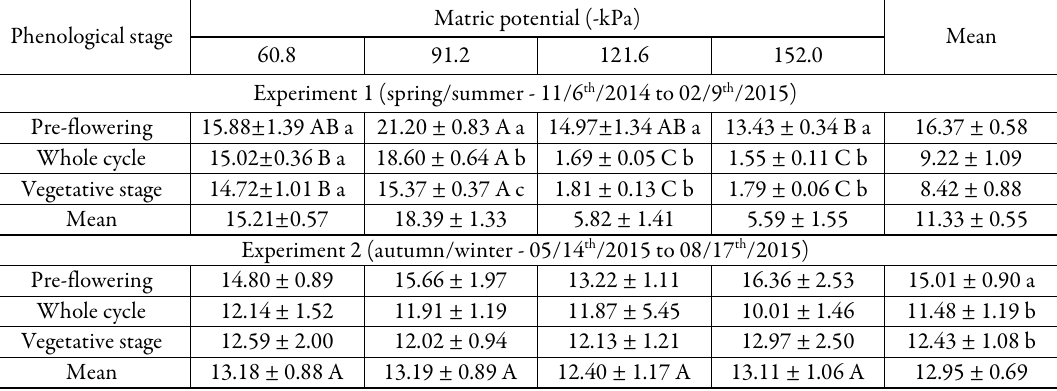
Table 2. Origanum vulgare L. dry biomass production within the experiments Phenological stage